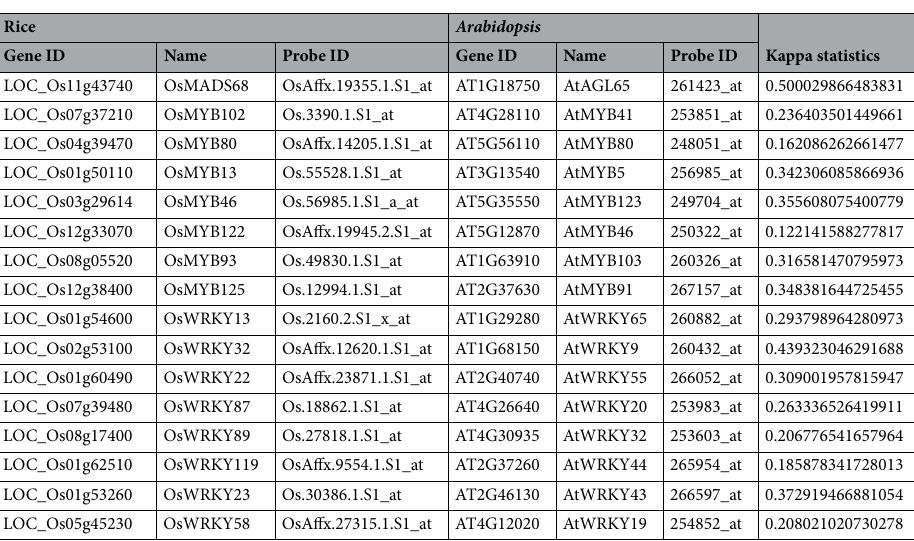
Table 3. Functional similarity between the Arabidopsis and rice WRKY, MADS-box and MYB orthologous gene-pairs. The co-expression datasets are retrieved and analyzed using Kappa statistics from